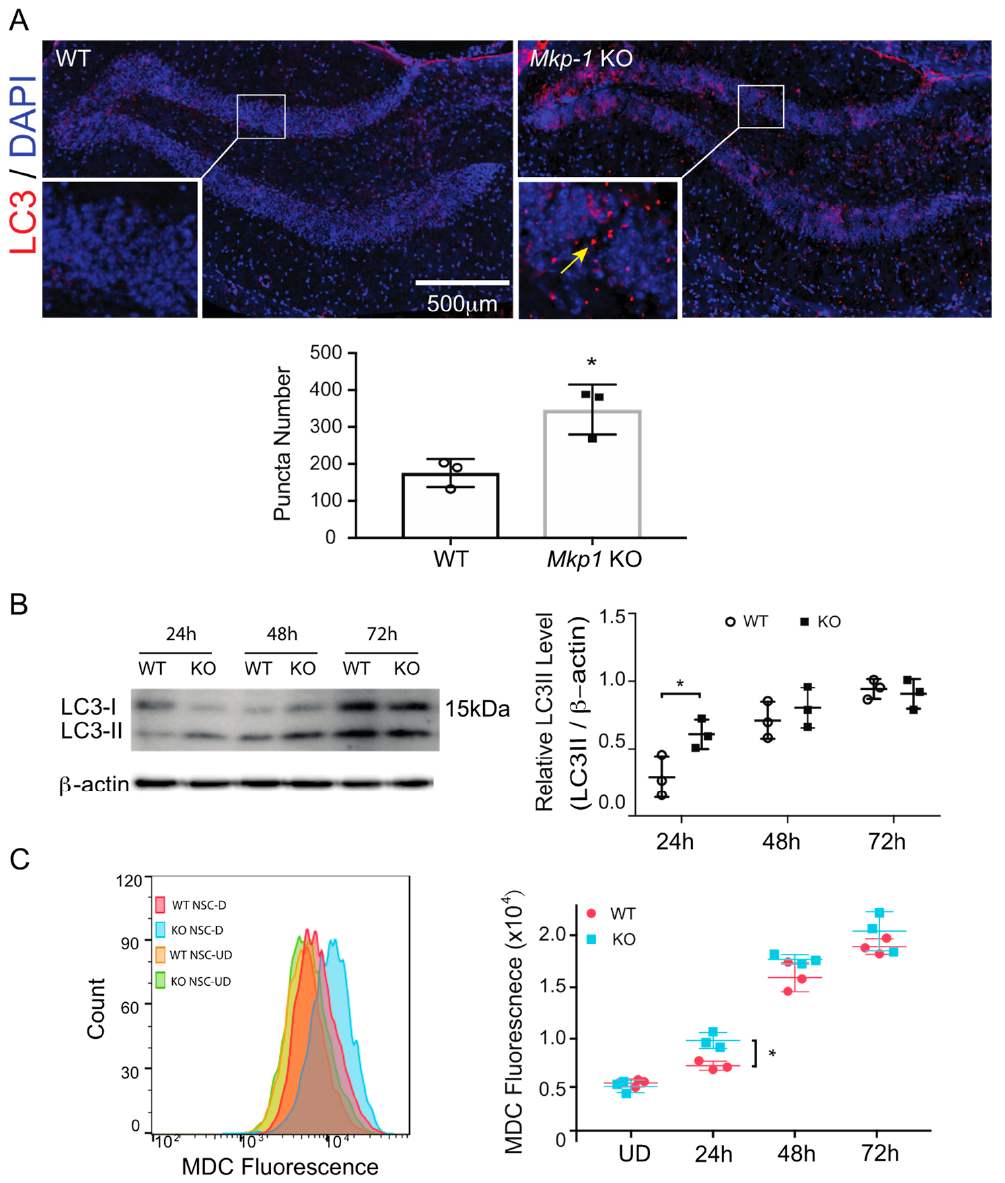
Figure 3. Loss of MKP-1 induces autophagy in the CNS and neural stem cultures. ( A ) LC3 immunofluorescence with DAPI counterstaining within the dentate gyrus of WT and Mkp-1 KO mice. The inset illustrates the increased accumulation of LC3 puncta (yellow arrow) in Mkp-1 KO mice. The number of puncta was compared between WT and Mkp-1 samples ( n = 3, t -test, * p < 0.05). ( B ) Western blotting ( Left ) and quantitative densitometry ( Right ) for LC3-II levels in neural stem cultures 24, 48, and 72 h post-differentiation in both genotypes ( n = 3, two-way ANOVA, * p < 0.05). ( C ) Flow cytometry analyses of autophagy in NSCs stained with monodansylcadaverine (MDC). Representative MDC fluorescence plots from undifferentiated (UD) and differentiated (D) NSCs ( Left ) and results comparing the effect of genotype on the median of MDC fluorescence over time ( Right ) are shown ( n = 3, two-way ANOVA, * p < 0.05).